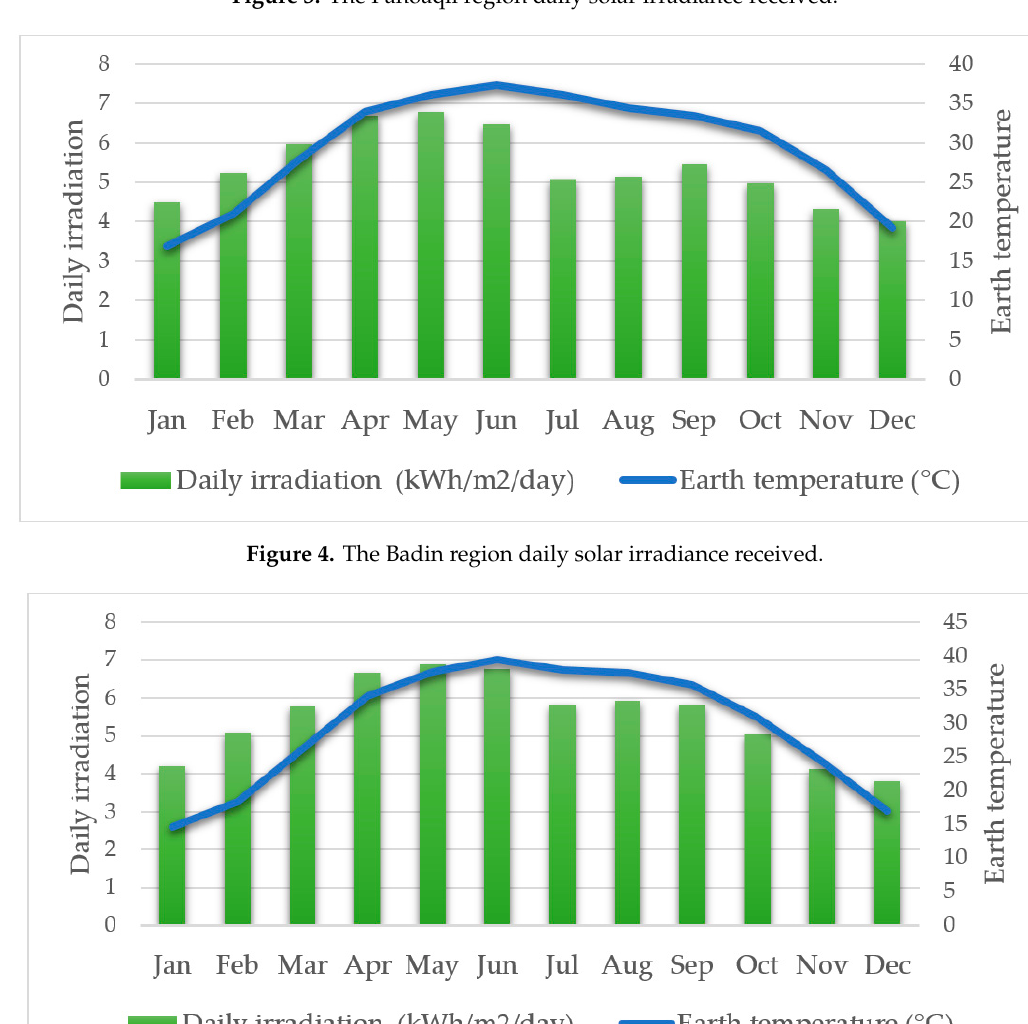
Figure 3. The Panoaqil region daily solar irradiance received.